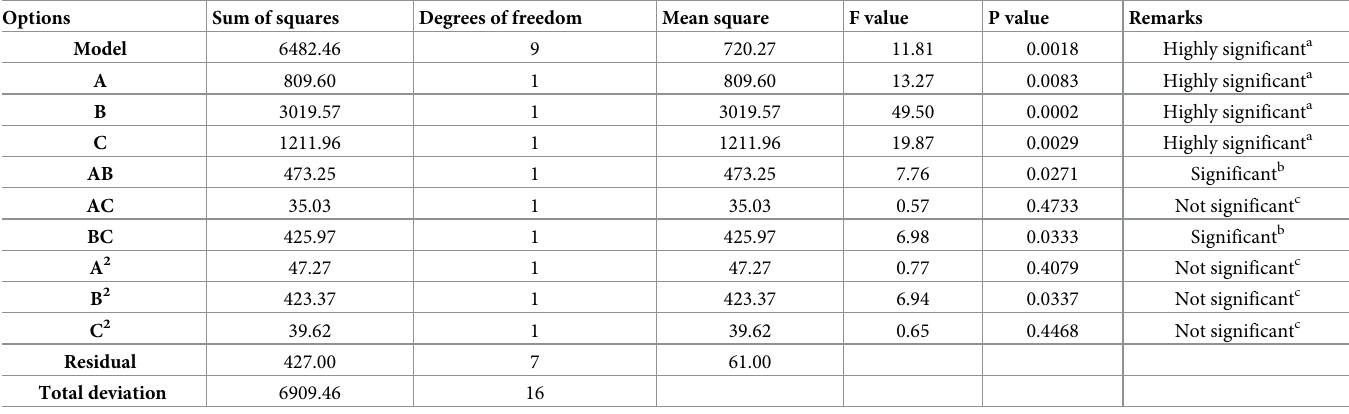
Table 4. Analysis of variance of test